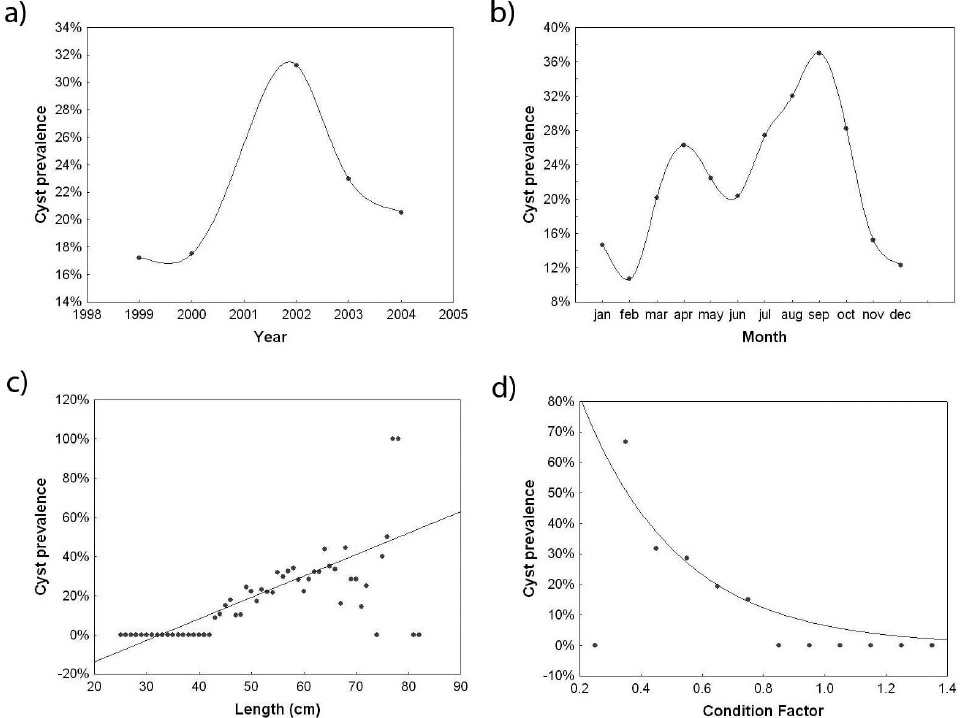
Fig. 4 . – For European hake: a) annual mean of cyst prevalence; b) monthly mean of cyst prevalence; c) linear relationship between cyst prevalence and female length (y=-0.3557+0.0109x); and d) exponential relationship between cyst prevalence and female condition factor